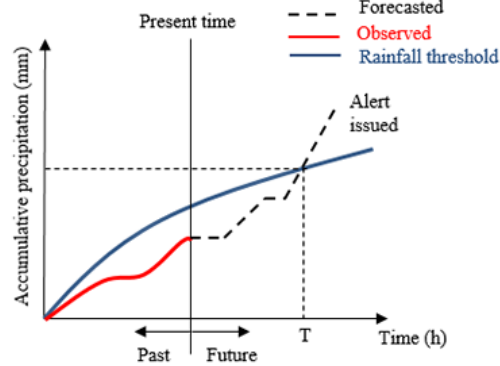
Figure 3. WRA issues an inundation alert when observed rainfalls meet or exceed any given rainfall thresholds (modified from Martina et al.,